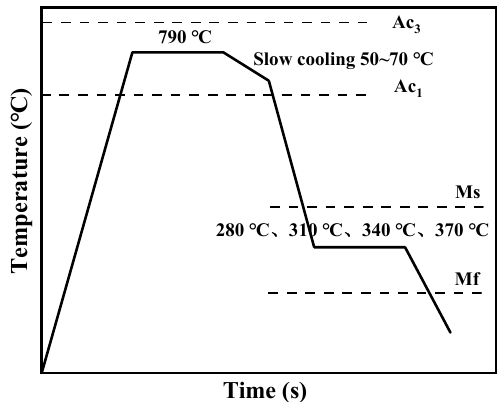
Figure 1. The schematic diagram of heat treatment. Subsequently, the annealed metallographic specimens were etched in 4% nitric acid alcohol solution for 6 s, and the microstructure was observed by the JEM-2800F field emission scanning electron microscope (SEM, JEOL, Beijing, China). Electrolytic polishing was carried out with alcohol perchlorate electrolyte and phase analysis was carried out with an X-ray diffractometer (XRD) in order to eliminate the possible stress during the mechanical polishing. Based on the results of XRD, the RA fraction and carbon content were calculated by the integral intensity of (200) γ , (220) γ , (311) γ , (200) α and (211) α peaks